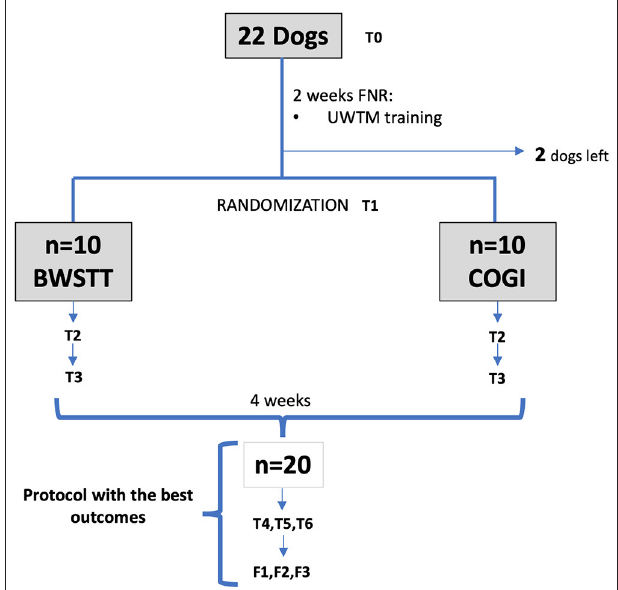
FIGURE 1 | Flow diagram describing the study design. FNR, Functional neurorehabilitation; UWTM, Underwater treadmill; T0, Admission; T1, After 2 weeks, randomization time; T2, After 1 week of specific protocol; T3, After 2 weeks of specific protocol; T4, T5, T6, After 3,4, and 5 weeks of the same protocol; F1, F2, F3, Follow-up after 1 week, 1 and 2 months. BWSTT, Body weight-supported treadmill training; COGI, conventional over-ground